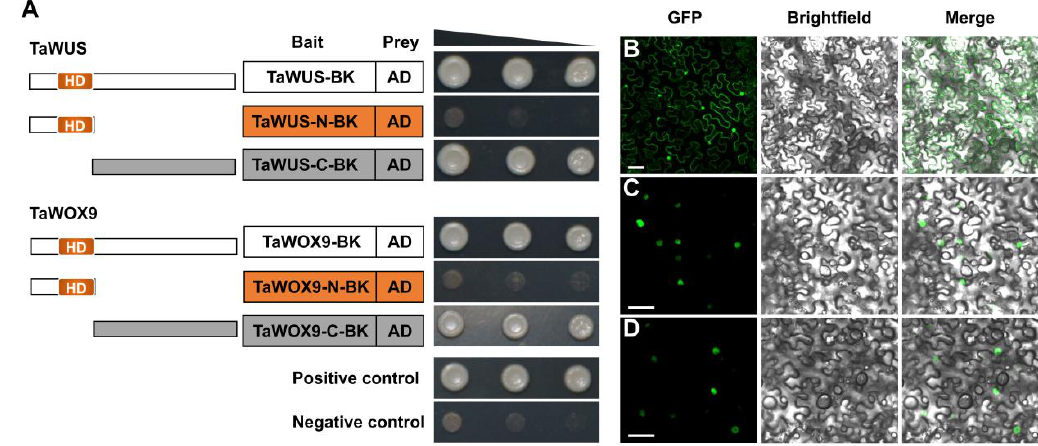
Figure 4. Nuclear-localized TaWUS and TaWOX9 exhibit transcriptional activity in yeast cells. ( A ) Transactivation assay of the TaWUS and TaWOX9 proteins. Full-lengths and the N- or C-terminal part of TaWUS and TaWOX9 were fused with the GAL4 DNA-binding domain and then expressed in yeast strain Y2H. The transformed yeast cells were diluted to the order of 10 − 0 , 10 − 1 , and 10 − 2 (gray triangle), and drops were deposited onto selective plates (SD / -Trp-His-Ade-Leu). Positive control, pGBKT7-53 and pGADT7-T vectors; Negative control, empty pGBKT7 (BK) and pGADT7 (AD) vectors. ( C , D ) enhanced green fluorescent protein (EGFP), TaWUS-EGFP, and TaWOX9-EGFP were transiently expressed in tobacco epidermal cells under the CaMV35S promoter. From top to bottom: EGFP ( B ), TaWUS-EGFP ( C ), and TaWOX9-EGFP ( D ). From left to right: GFP fluorescence, bright field, and merged microscope images. Scale bars = 50 μm.